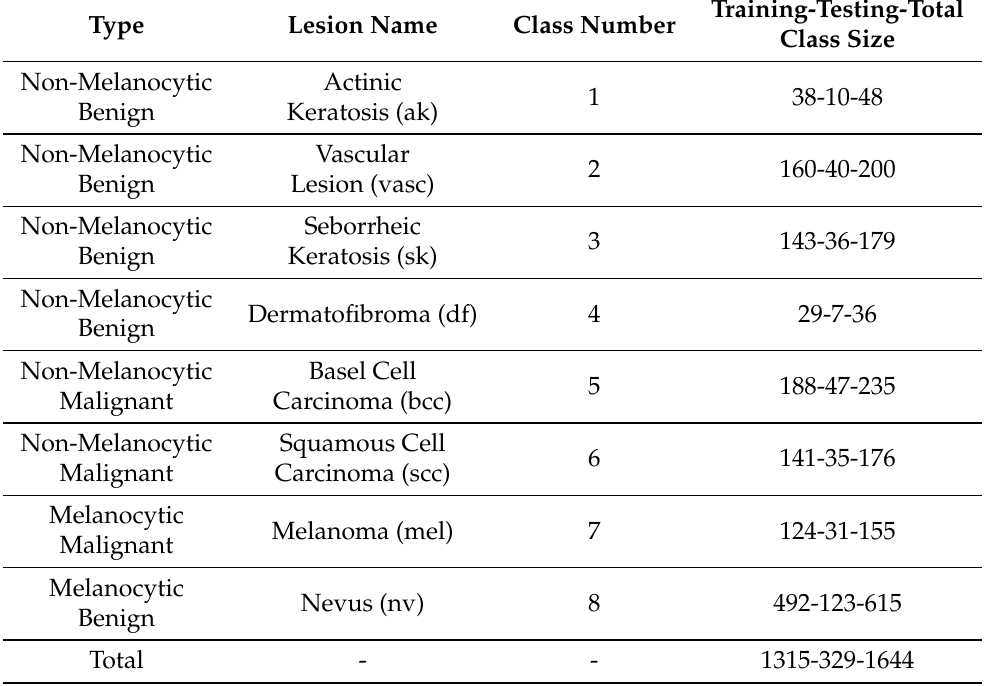
Figure 2. Classification of skin cancer lesions by groups and subgroups. Green background represents benign lesions, and red background represents malignant lesions. Table 1. The lesion types, names, class number and dataset